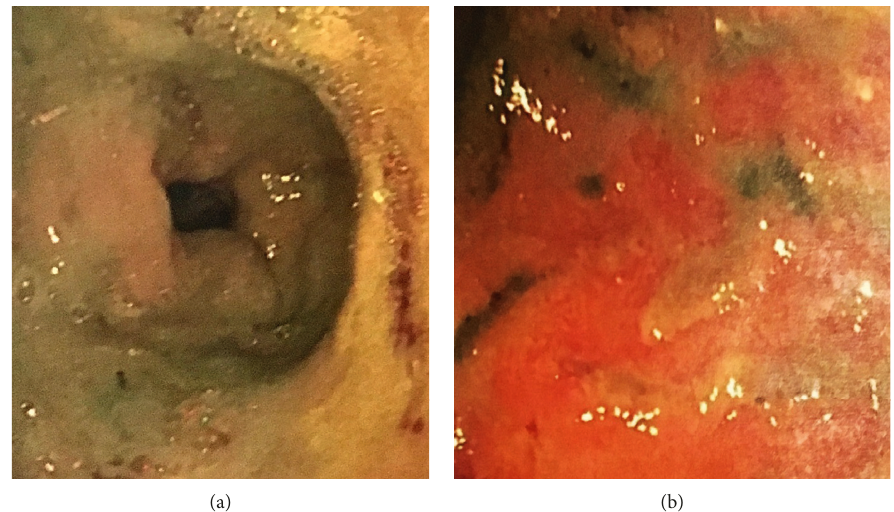
Figure 1: Endoscopy showed patchy redness and thickened gastric folds including an exudate involving the gastric antrum and the first part of the duodenum.